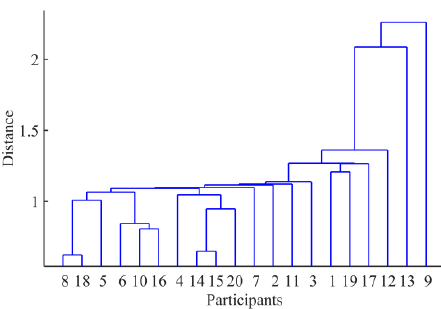
Figure 5. Cluster analysis of subjective experimental results. In the figure, the x-coordinate and the y-coordinate denote the subject number and the calculated distance, respectively. The larger the distance, the greater the difference between the participant’s evaluation result and other participants’.